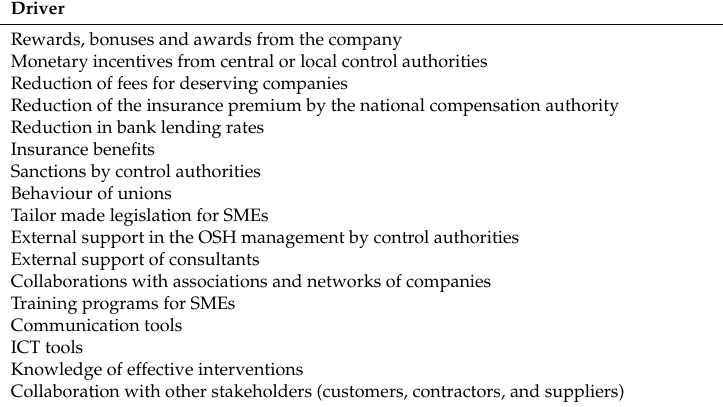
Table 4. Drivers.